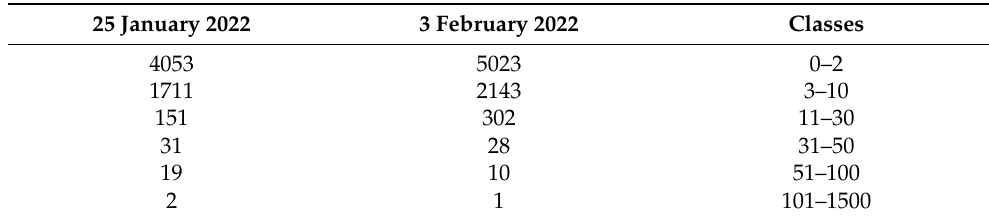
Table 5. Word-pairs